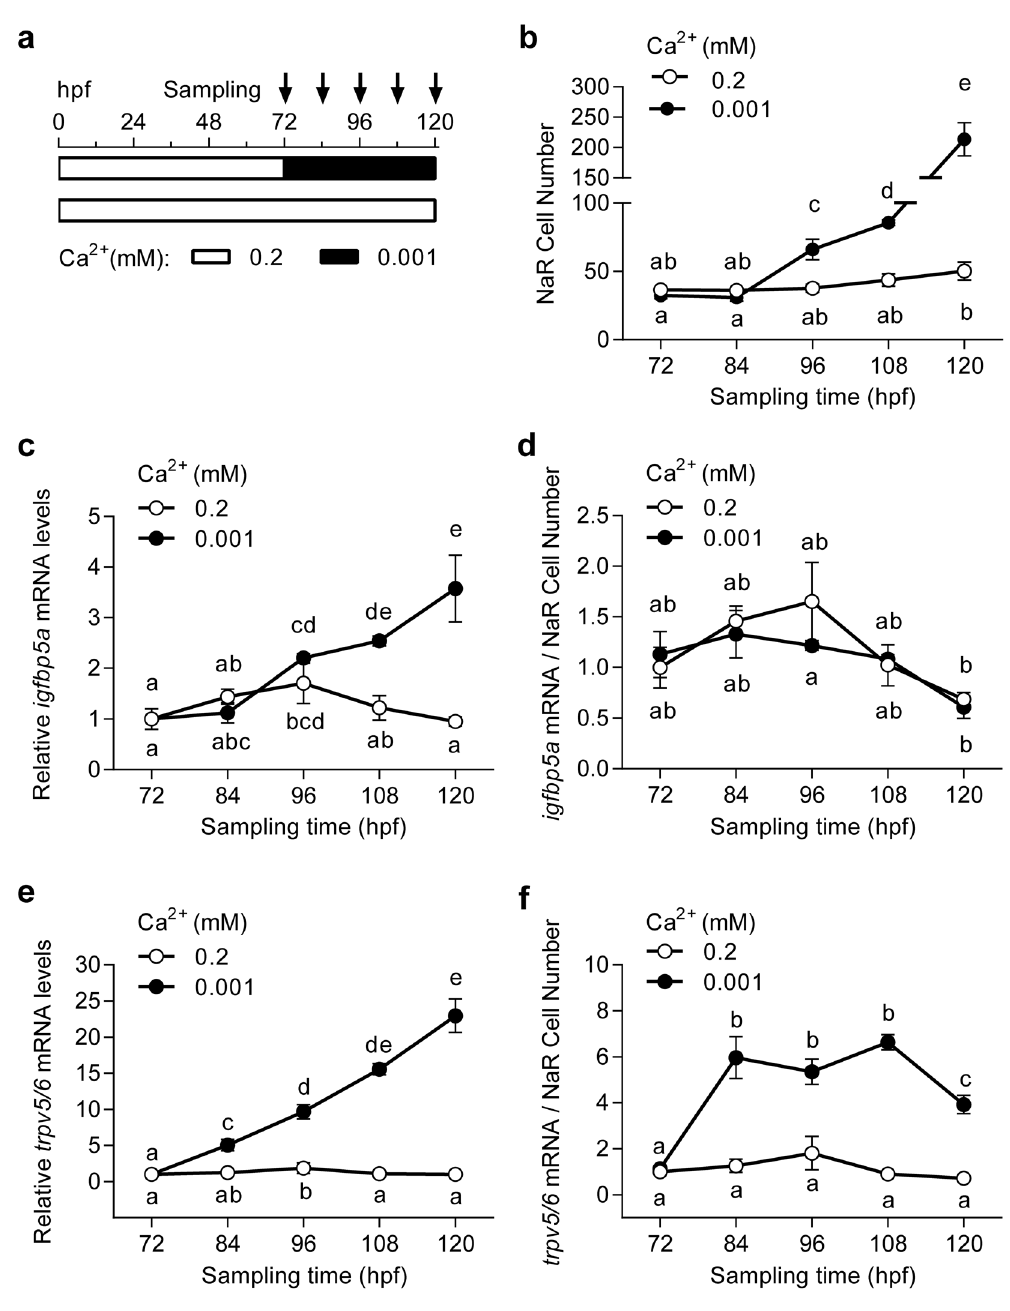
Figure 2. The igfbp5a mRNA levels are correlated with NaR cell number. ( a ) The experimental design. ( b ) Larvae described in ( a ) were analyzed by in situ hybridization for igfbp5a mRNA expression. The NaR cell number on one side of yolk sac was manually counted. ( c ) Total igfbp5a mRNA levels measured by qRT-PCR and by normalized by β -actin mRNA levels. ( d ) The igfbp5a mRNA levels shown in ( c ) are normalized by NaR cell number shown in ( b ). ( e ) The trpv5 / 6 mRNA levels measured by qRT-PCR and by normalized by β -actin mRNA levels. ( f ) The trpv5 / 6 mRNA levels shown in ( e ) are normalized by NaR cell number shown in ( b ). All data shown above are mean ± SEM, n = 3. Different letters indicate significant differences at p <